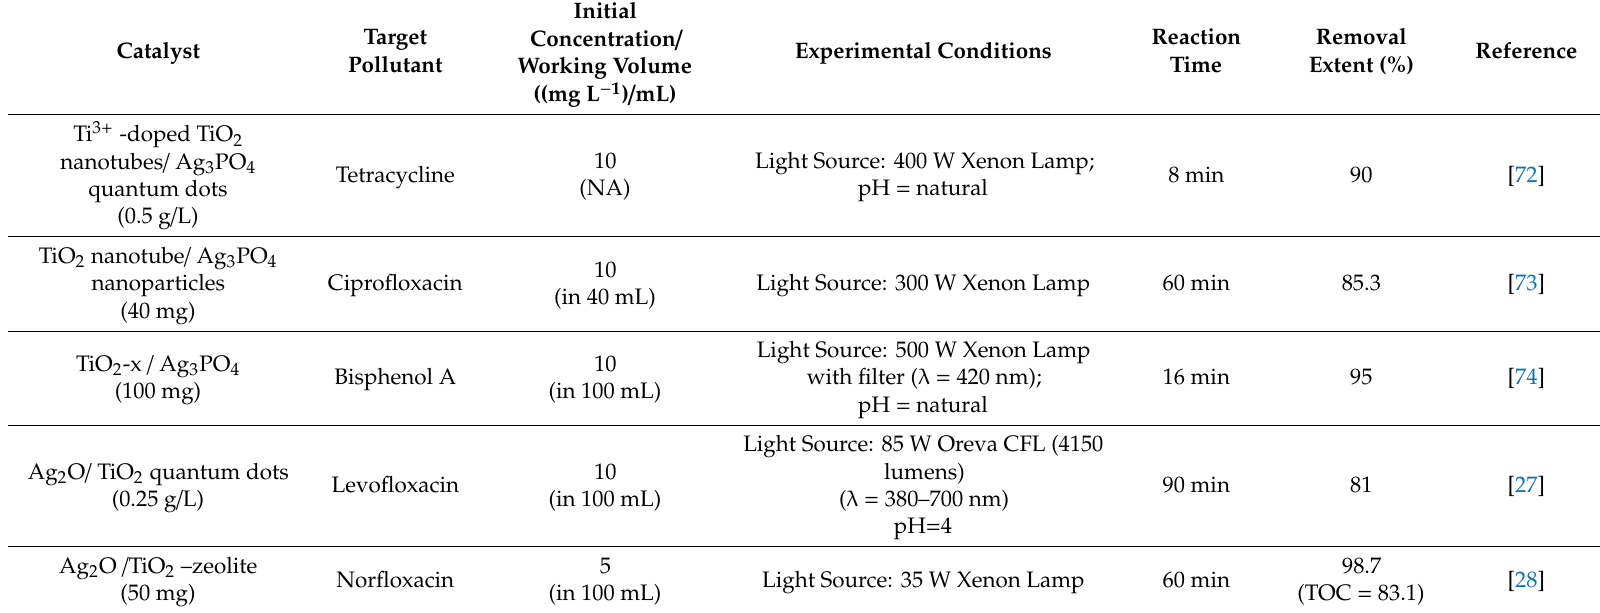
Table 7. Photocatalytic degradation of CEC’s over TiO 2 / Silver-Based Semiconductor